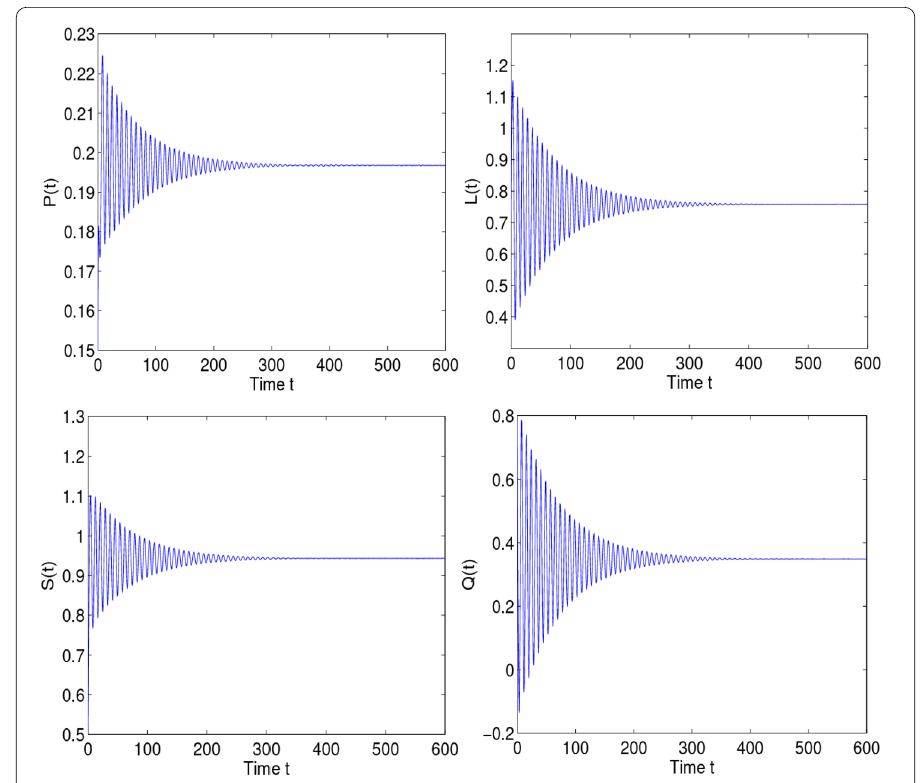
Figure 1 Time plots of P , L , S and Q for τ = 2.6865 < τ 0 = 2.7958